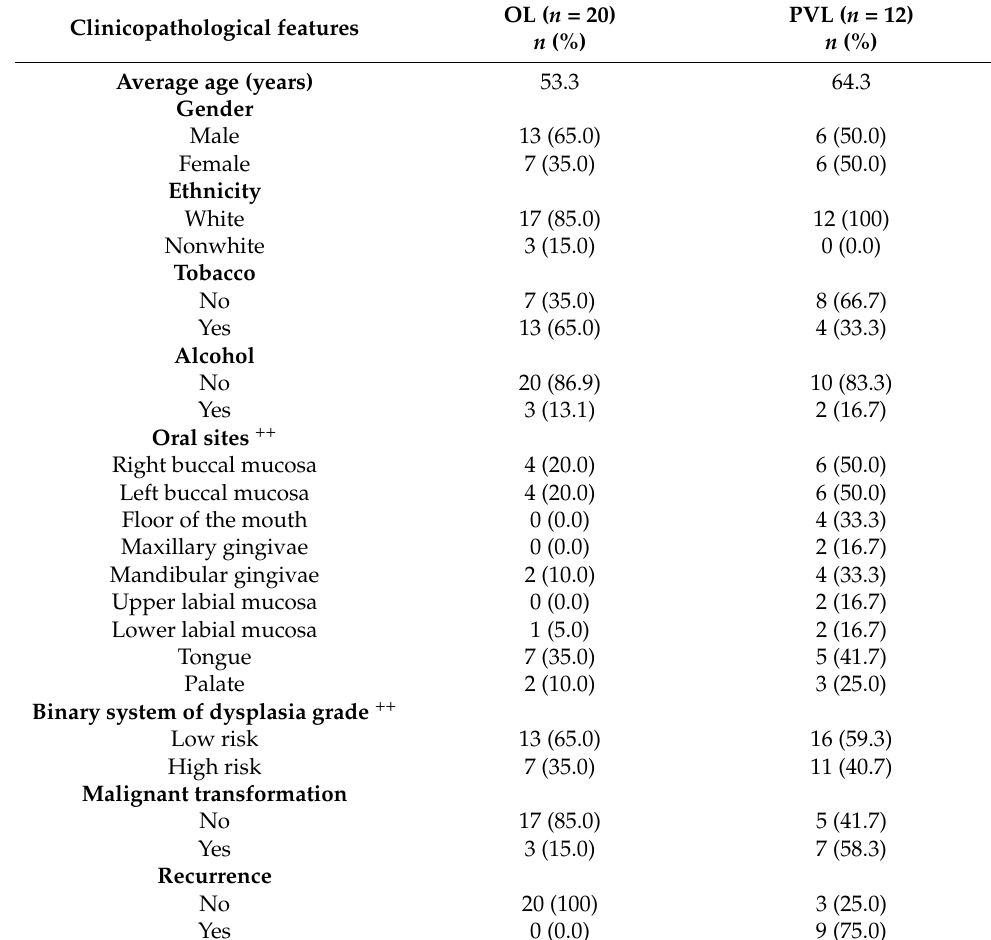
Table 1. Clinicopathological characteristics of enrolled patients in our study and diagnosed with OL and